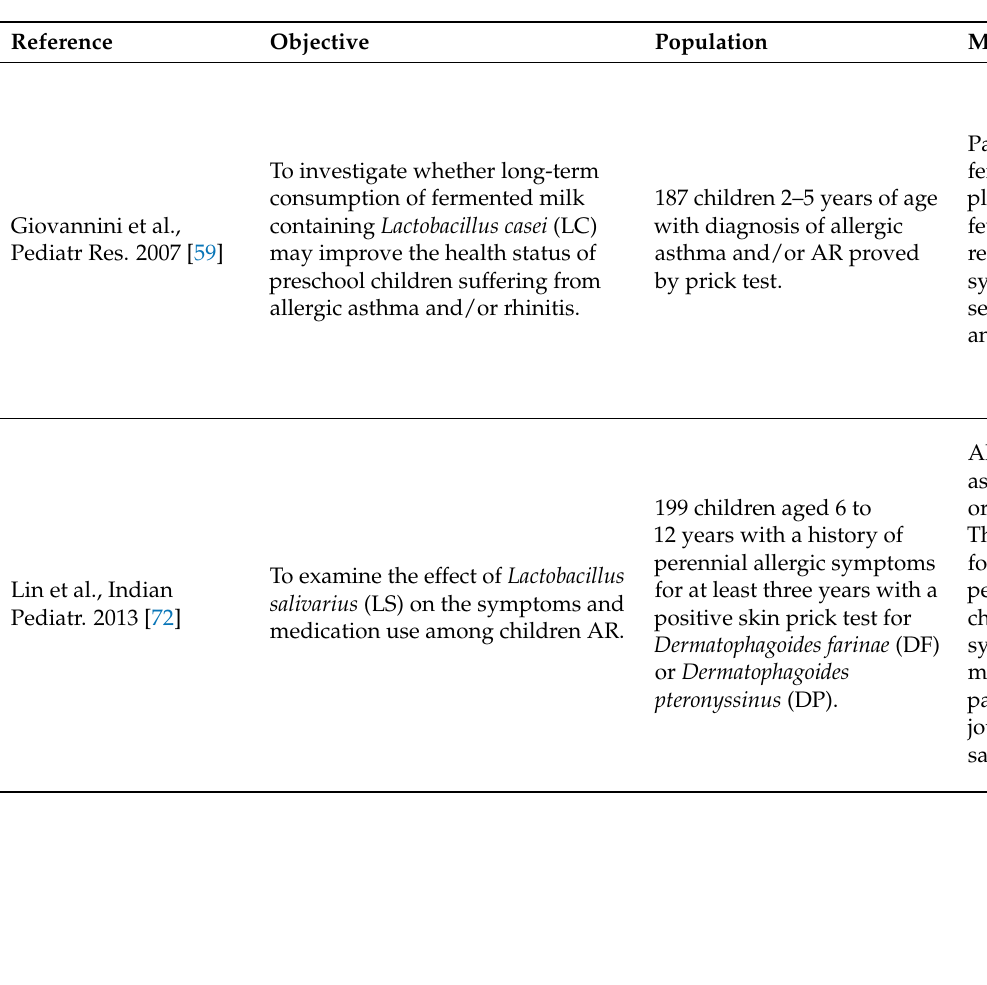
Table 1. RCTs on Lactobacilli in children with